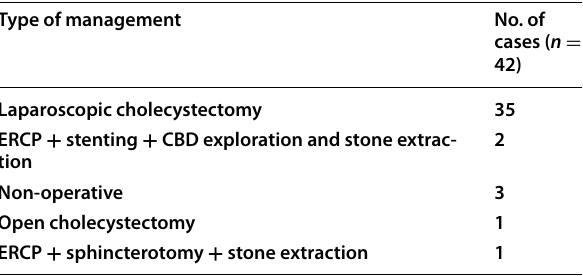
The majority were managed by laparoscopic cholecystectomy